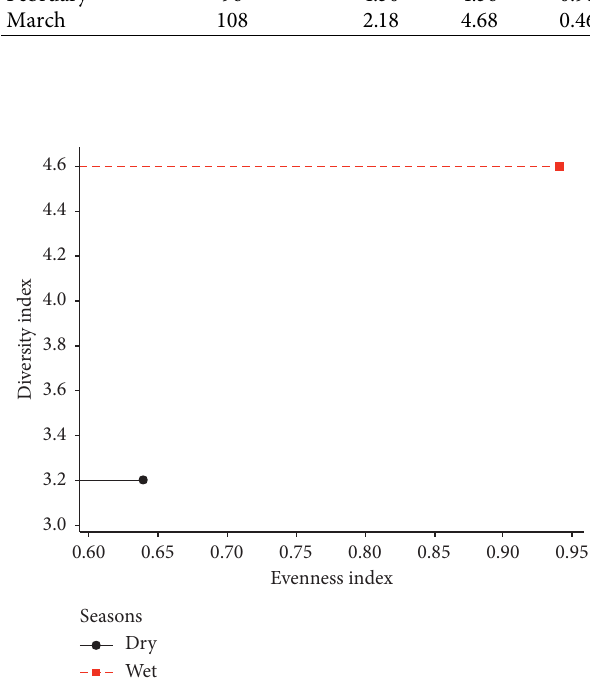
Figure 3: Seasonal diversity and evenness index of bird